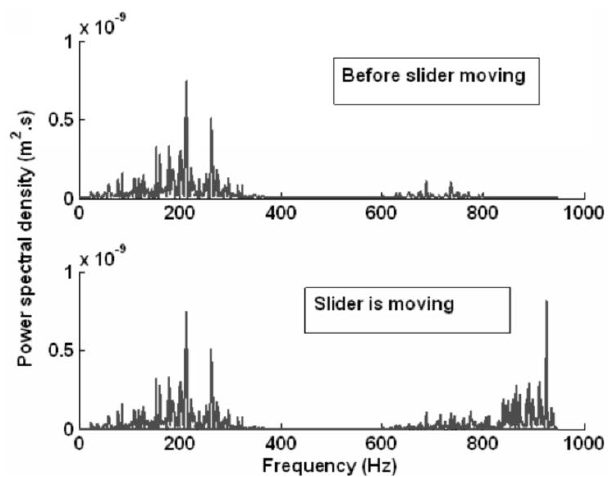
Figure 5. Measured result of the aerostatic